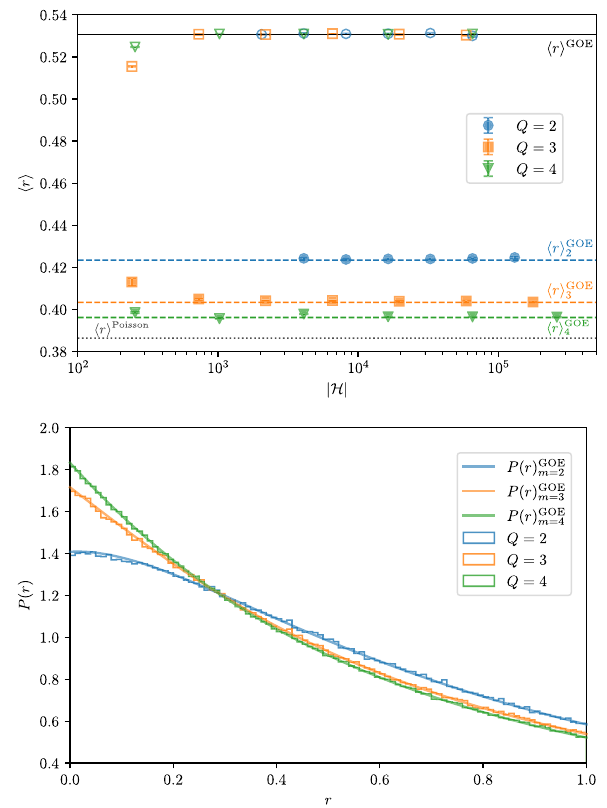
FIG. 5. The Q -state clock model. Top panel: average gap ratio h r i for the model of Eq. (62) for different values of Q , as a function of Hilbert space size j H j . Open symbols denote simulations where the Z symmetry is resolved, in which case Q the Hilbert space size is the block size Q L − 1 (we averaged data over all Q equivalent blocks). Filled symbols denote results for the full Hilbert space of size Q L . The dashed lines represent the obtained in Sec. III (taken from Table II), while values of h r i GOE m h r i GOE is the numerical estimate for the GOE distribution taken from Ref. [18]. The precision of our numerics allows us to clearly distinguish the case m ¼ 4 blocks with h r i GOE from the Poisson m ¼ 4 value h r i Poisson , also represented in the plot. Simulation param- eters are ϵ ¼ 0 . 5 , J ¼ 1 , Γ ¼ 0 . 8 , and g ¼ 0 . 5 . For Q ¼ 2 , instead of the time-reversal and charge conjugation breaking term in Eq. (62), which vanishes when Q ¼ 2 , we add a next- P σ σ nearest-neighbor interaction g 2 in order to break the j j þ 2 j mapping to a free-fermion model (we take g 2 ¼ 0 . 5 ). Statistics are obtained by focusing on 200 Q eigenstates in the middle of the full spectrum, except for the smaller sizes where about 20 Q eigenstates were considered. Results are averaged over more than 4000 realizations of disorder, except for the largest size where 1000 realizations were used. For Q ¼ 2 , 3, 4, we obtained results on chains of sizes up to L ¼ 17 , 11, 9, respectively. Bottom panel: probability distribution of the gap ratio P ð r Þ , as obtained from simulations of chains of sizes L ¼ 16 , 10, 8 for Q ¼ 2 , 3, 4, respectively. Simulation parameters are the same as in the top r Þ obtained panel. The solid lines represent the surmises P GOE m ð from the analytical computations in Sec.